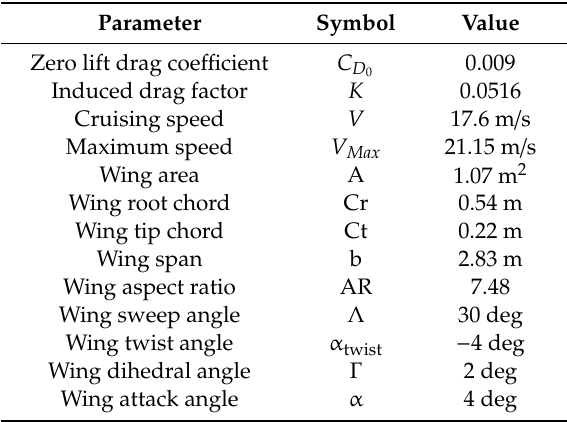
Figure 5. Relationship between the lift coe ffi cient and the angle of attack and relationship between the pitching moment coe ffi cient and the angle of attack. Table 2. Main aerodynamic